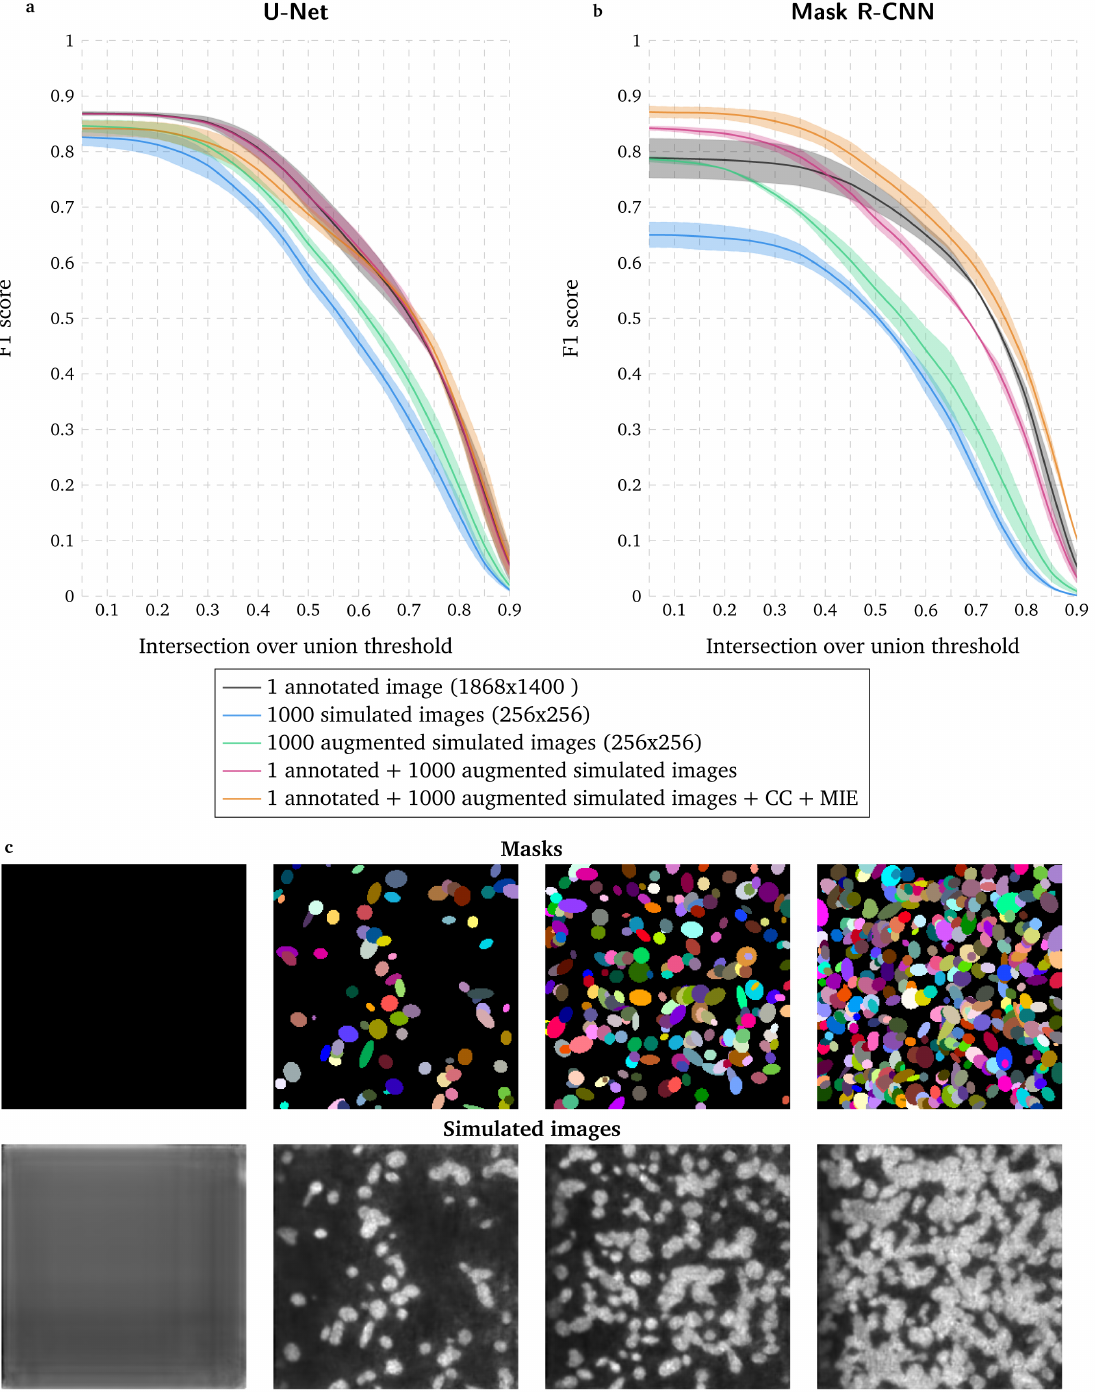
Figure 2. Evaluation of deep learning-based segmentation when using a conditional Generative Adversarial Network to increase the size of the training dataset. a First row: masks generated as ellipses (see Methods) and represented with unique colors. Second row: images simulated from masks shown in first row with a conditional Generative Adversarial Network (GAN). b – c F1 score for range of IoU thresholds obtained with U-Net b and Mask R-CNN c trained with 1 annotated image with data augmentation (DA), 1000 simulated images, 1000 augmented simulated images, 1 annotated image with DA combined with 1000 augmented simulated images and 1 annotated image with DA combined with 1000 augmented simulated images as well as a high-throughput chemical screen on U2OS cells dataset (CC) and a widefield mouse intestinal epithelium dataset (MIE). Lines correspond to average F1 score over the two tested images while the shaded areas represent the standard